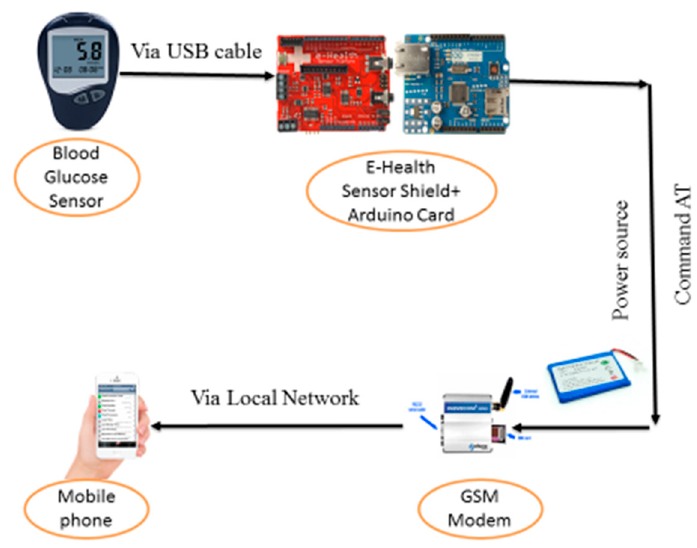
Figure 7. Hardware installation.